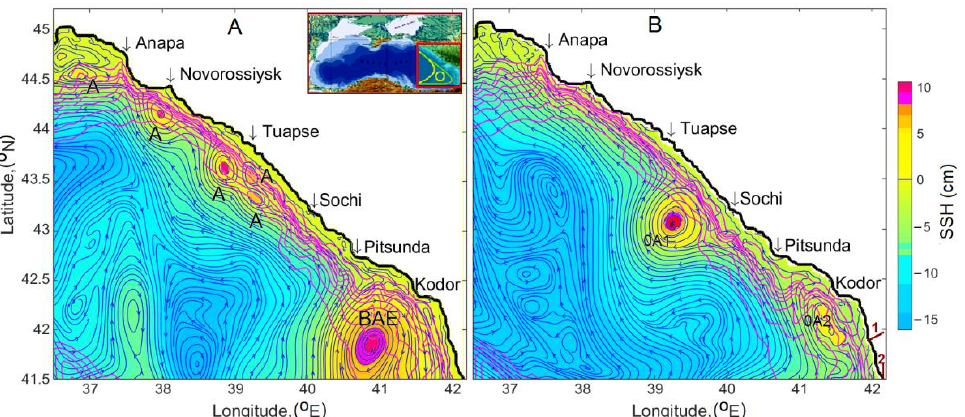
Figure 5. Snapshot of streamline structures and sea surface height (SSH) associated with the evolving of: ( A ) eddy-chain marked by letters A; and ( B ) the Caucasian anticyclonic eddy (0A1). The BAE and 0A2 denote the Batumi and Rioni anticyclonic eddies, respectively; 1 and 2 denote the Inguri and Rioni rivers, respectively. Magenta lines show isobars of 100, 300, 500, 750, 1000, 1250, 1500, and 1750 m. In the inset, solid lines show the conventional positions of the RC at the easternmost part of the Black Sea in summer (yellow) and winter (green). The yellow ring shows the conventional position of the BAE in the spring–summer